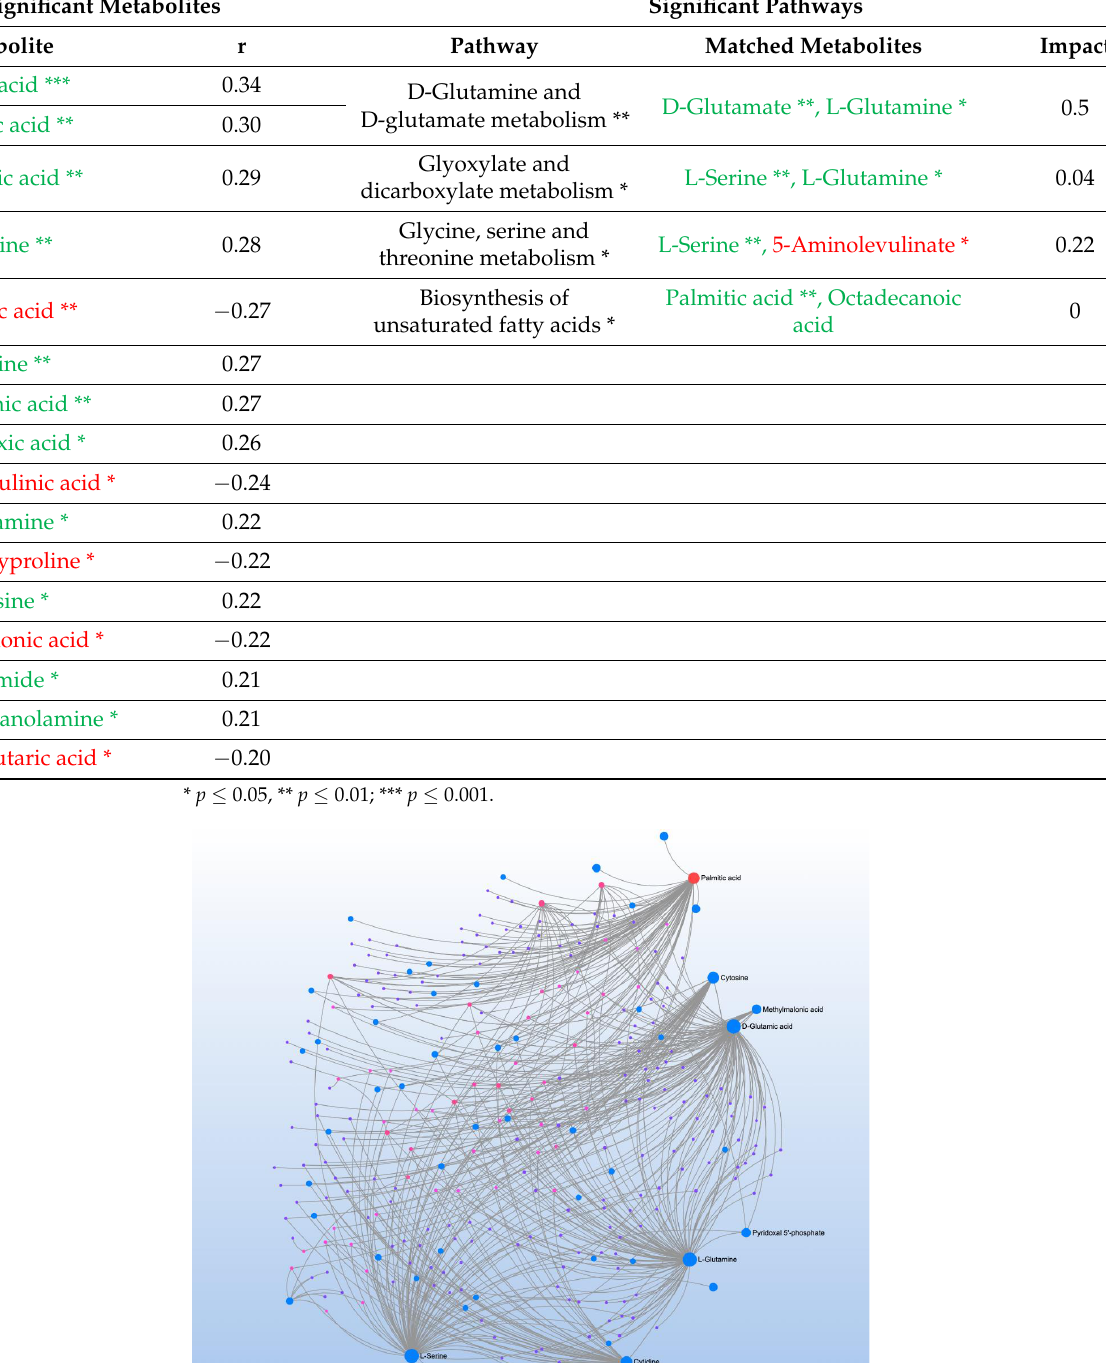
Table 14. Metabolites and their pathways which correlate with oxidative damage